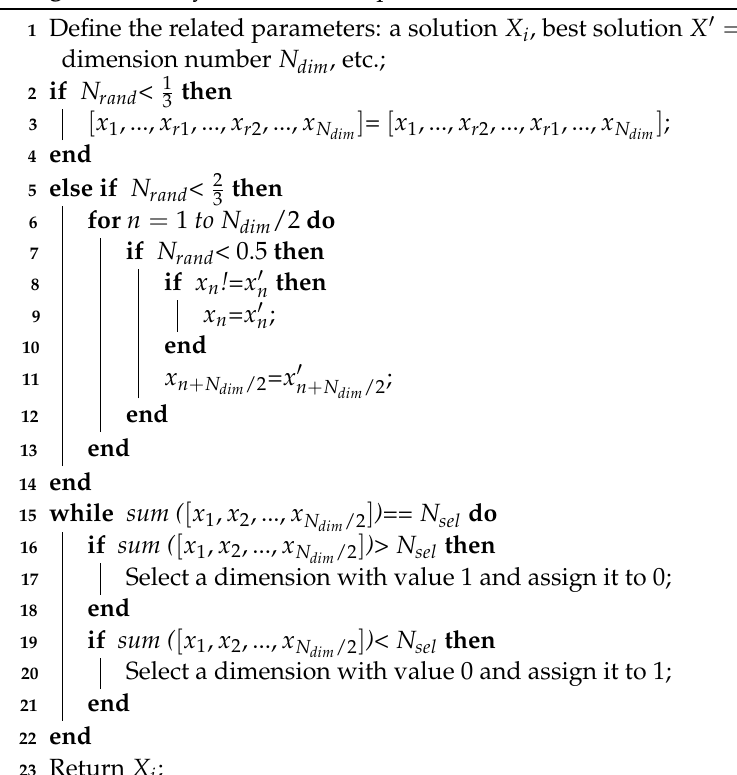
Algorithm 2: Hybrid Solution